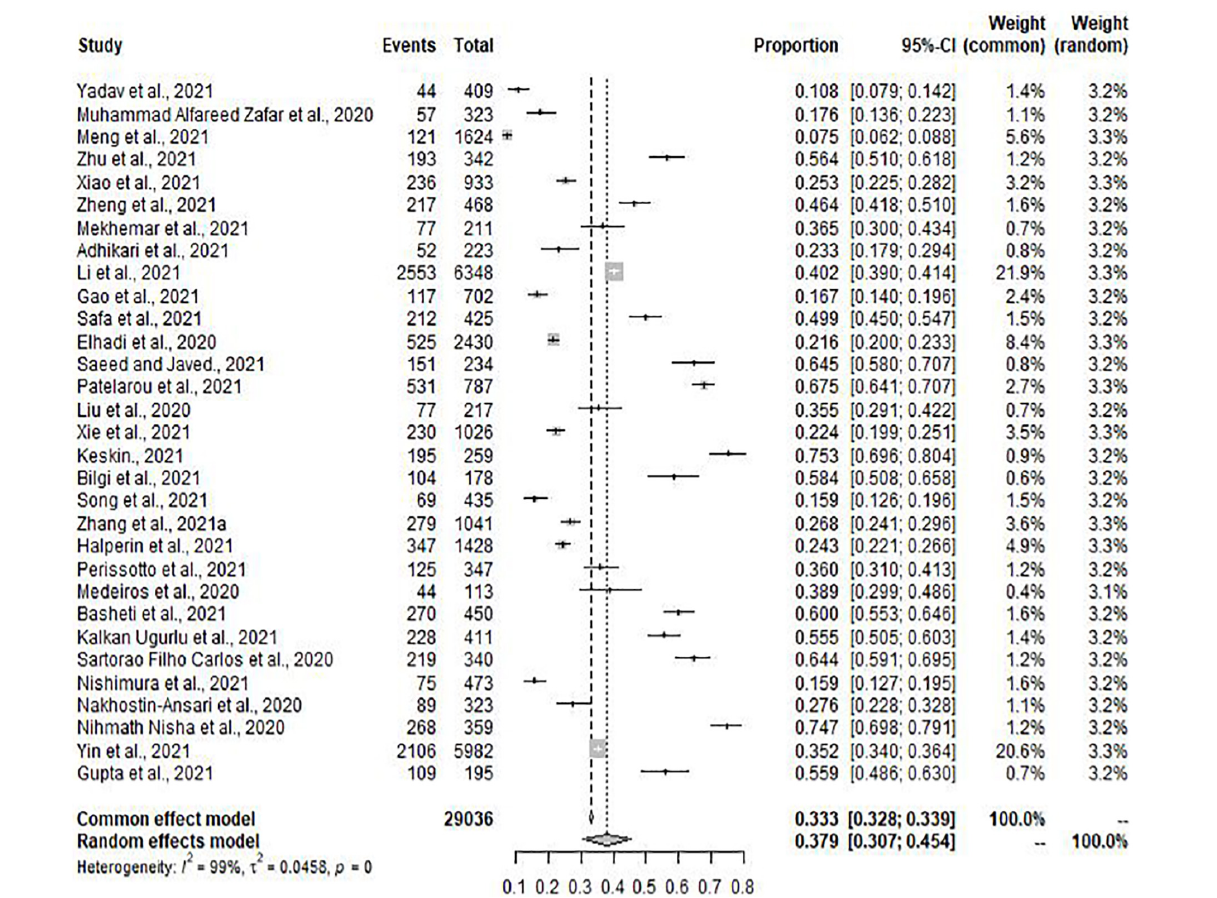
FIGURE 2 | Forest plot for